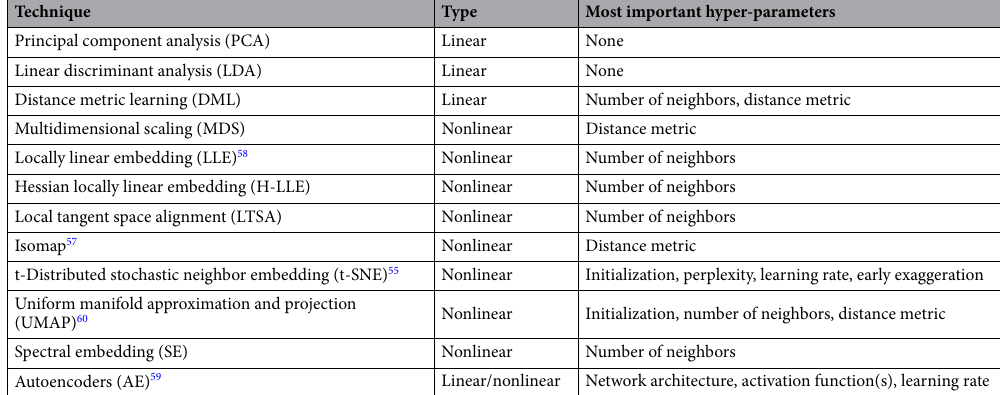
Table 2. Dimensionality reduction and manifold learning techniques used in this work. In the last column, we list the most important hyper-parameters of each method. The cost function can help fine-tune the hyper- parameters to achieve quality manifold